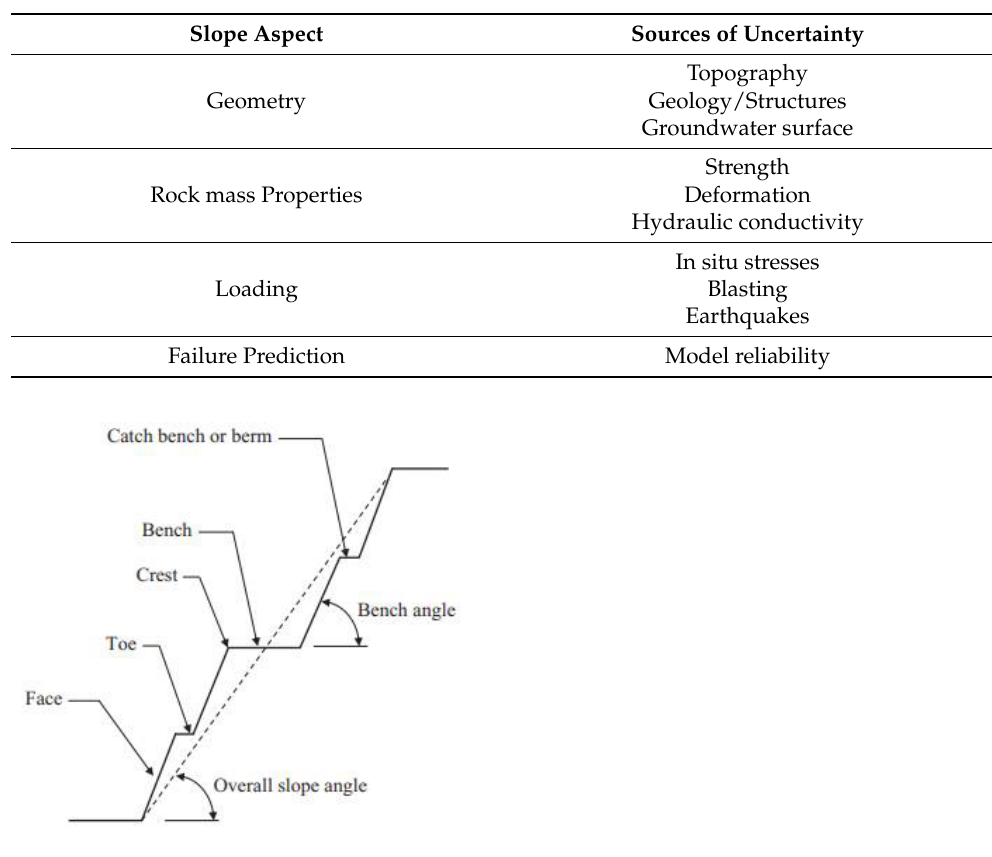
Figure 10. Schematic diagram showing open-pit bench slope parameters (Adapted from